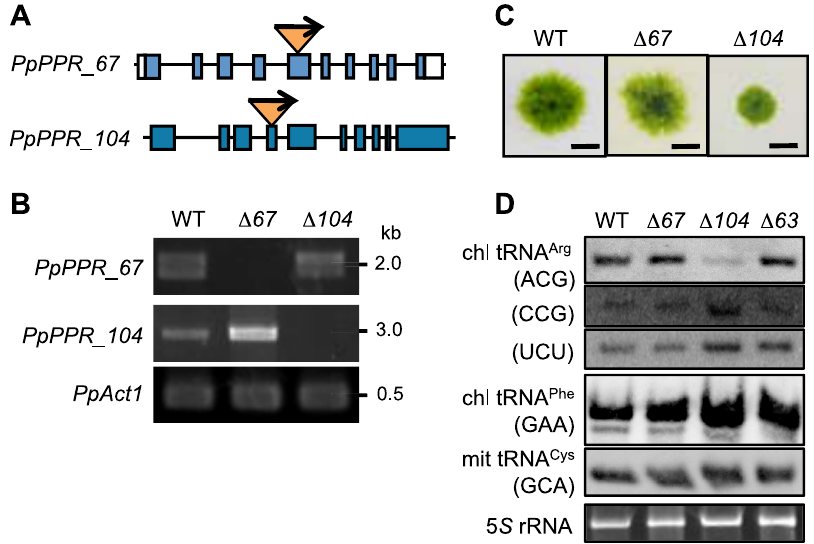
Figure 5. PpPPR_67 and PpPPR_104 KO mosses. ( A ) Schematic structure of PpPPR_67 and 104 KO loci. The nptII cassette was inserted into the 5th exon of PpPPR_67 and the 4th exon of PpPPR_104 . ( B ) Detection of PpPPR_67 and 104 transcripts by RT-PCR. ( C ) Two-week-old protonemata colonies of the PpPPR_67 KO line ( D 67 ) and the PpPPR_104 KO line ( D 104 ). Scale bars =5 mm. ( D ) Steady-state levels of chloroplast (chl) tRNA Arg isoacceptors with different anticodons, chl tRNA Phe (GAA) and mitochondrial (mit) tRNA Cys (GCA).